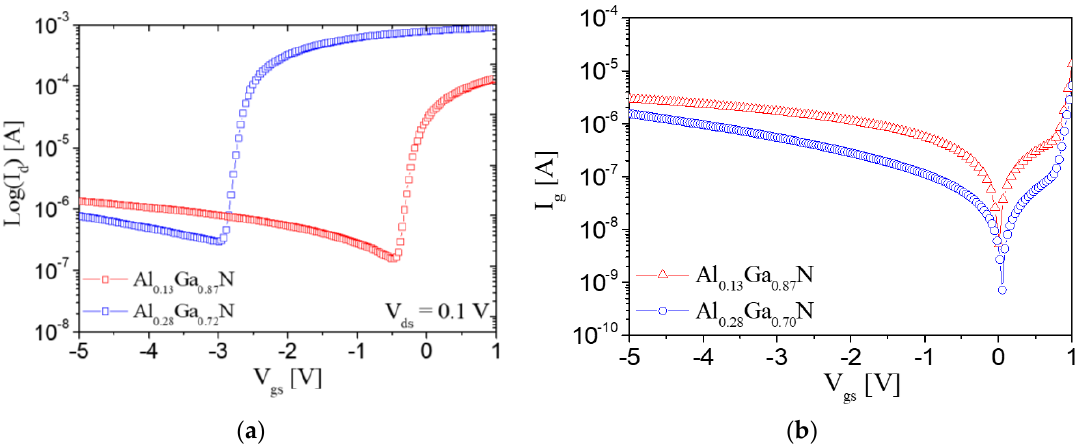
Figure 2. ( a ) Drain current (logarithmic scale); ( b ) gate leakage current of AlGaN/GaN HEMTs with different Al compositions. di ff erent Al